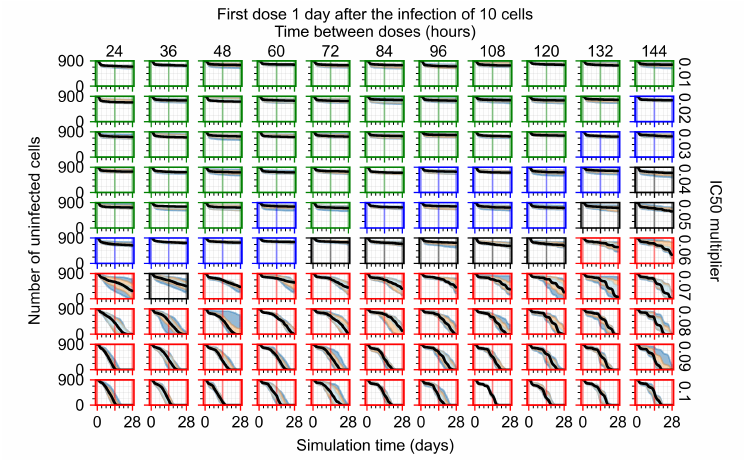
Figure A21. Uninfected population.